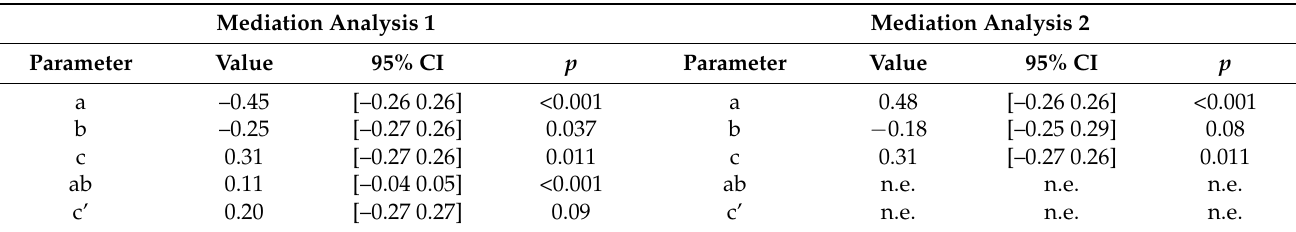
Table 4. Summary of mediation